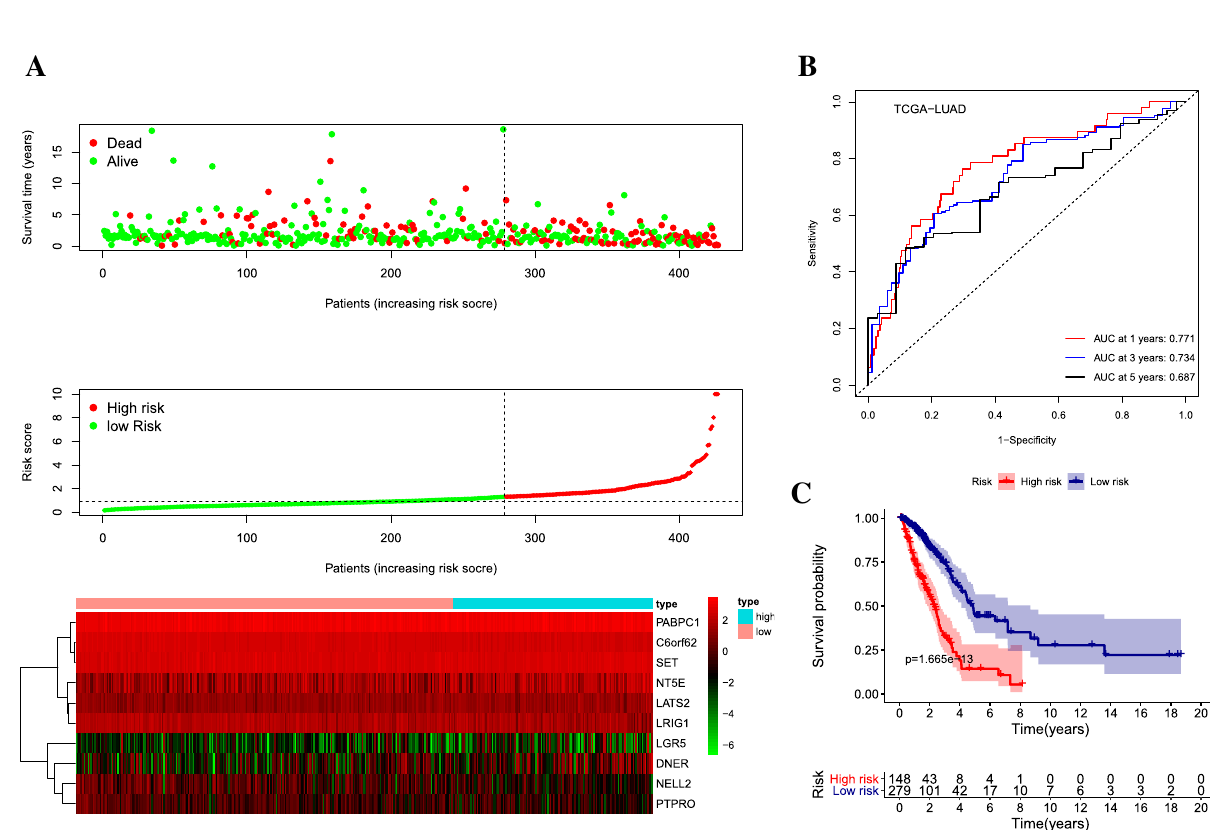
Figure 1. Construction of signature. ( A ) The risk curve in the TCGA cohort displayed the patients’ risk score, survival time, and status, and expression of stem cell-related genes. The scales represented the expression level of each gene in each sample, which was established based on z-score transformed expression data. ( B ) ROC curve illustrated the risk prediction of the signature for 1, 3, and 5-year in the TCGA cohort. ( C ) Kaplan–Meier survival revealed the overall survival among different risk stratification